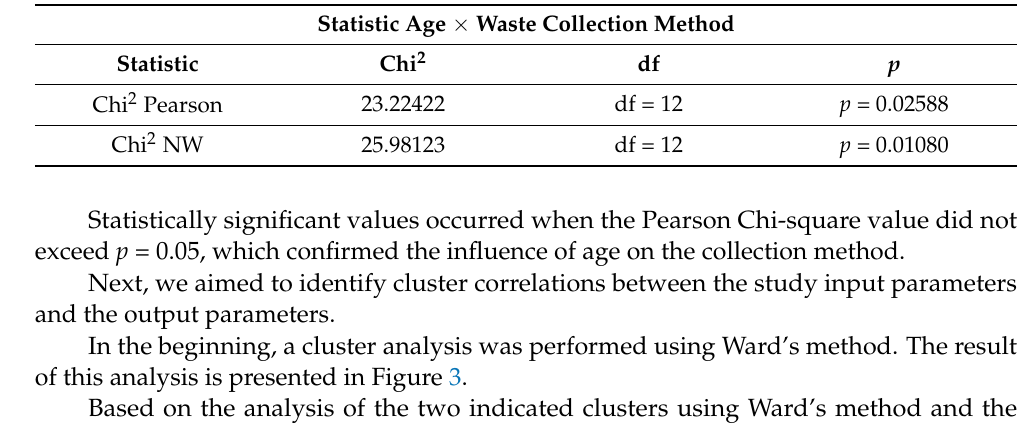
Table 5. Chi-square statistics and its components taking into account age and waste collection